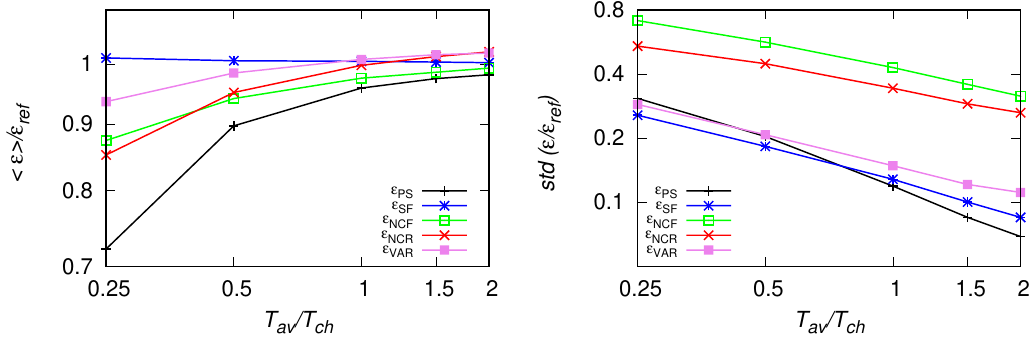
Figure 4. Statistics of EDR estimates for the fitting range f = [ 10 ÷ 20 ] Hz, or f cut = 20 Hz from artificial signals with f s = 200 Hz. Left panel : EDR averaged along the signal, right panel : standard deviation of the estimates. EDR estimates based on the power spectrum (cid:101) PS , Equation (6), structure function (cid:101) SF , Equation (7), number of zero-crossings scaling in the inertial range (cid:101) NCF , Equation (9), iterative method based on the velocity variance (cid:101) VAR , Equation (10) and the number of zero-crossings per unit length, Equation (12).